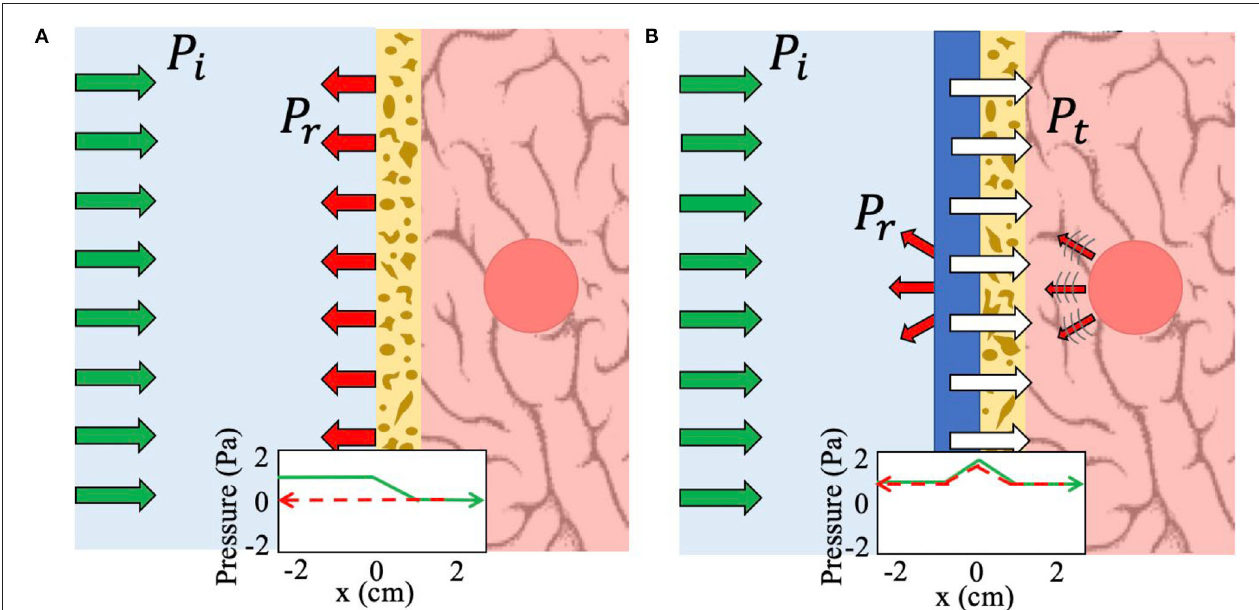
FIGURE 1 | Schematic of the working principle of NHCMM. Green arrows indicate incident pressure (P i ), red arrows reflected pressure (P r ), and white arrows transmitted pressure (P t ). (A) Imaging without any metamaterial compensation results in complete reflection and scattering due to the lossy skull. A graphical representation of the bidirectional acoustic pressure field demonstrates this loss as the pressure amplitude falls to zero as the acoustic wave passes through the skull at x 0 (green arrow) and thus no reflected pressure can be detected (red dashed arrow). (B) Imaging with the NHCMM results in complete bidirectional transmission = of the acoustic wave, including ultrasound imaging information of the tumor presence and location. The corresponding graph of the acoustic pressure field shows clear acoustic gain to counteract the subsequent loss caused by the skull as the signal passes into the brain (green arrow). The reflected pressure amplitude is also preserved through the NHCMM/skull bilayer (red dashed arrow).